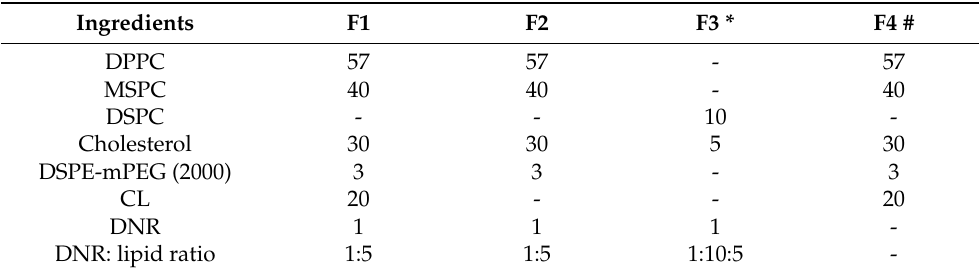
Table 3. Composition of various thermosensitive liposomal formulations. The quantities of lipids are expressed in molar ratios (with no